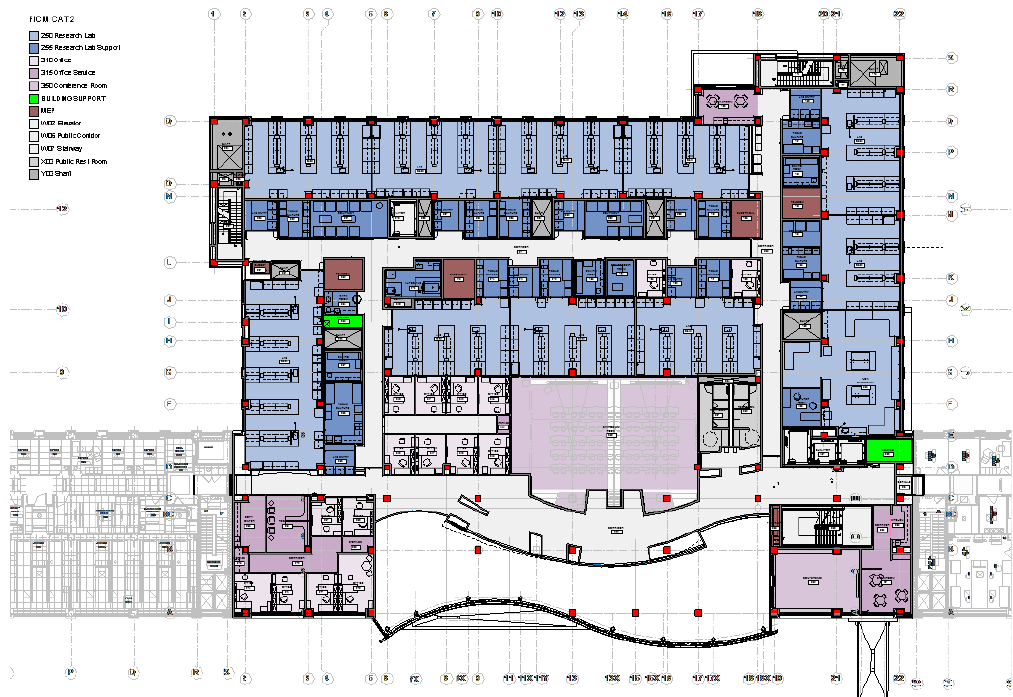
Figure 2 An example of sub-department classification of the Walther Hall floor plan (Image copyright: